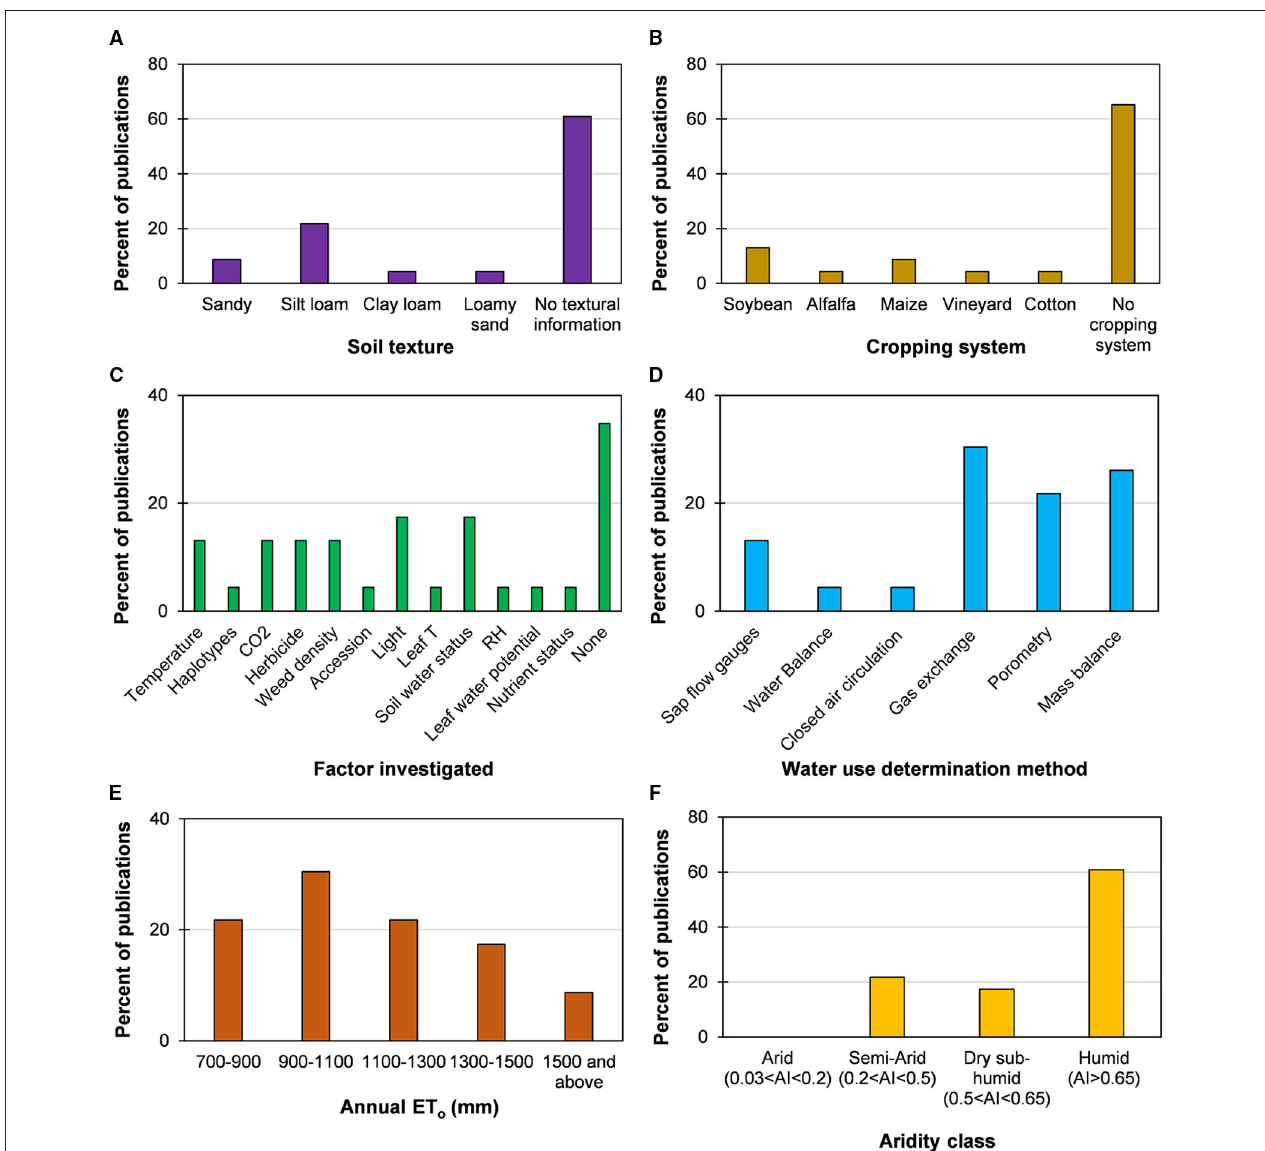
FIGURE 4 | Percentage of publications that present weed water use (WU) in various classes of (A) soil texture, (B) cropping system, (C) factors investigated for the impact on WU, (D) method used to determine WU, (E) annual evapotranspiration (ET o ), and (F) aridity index